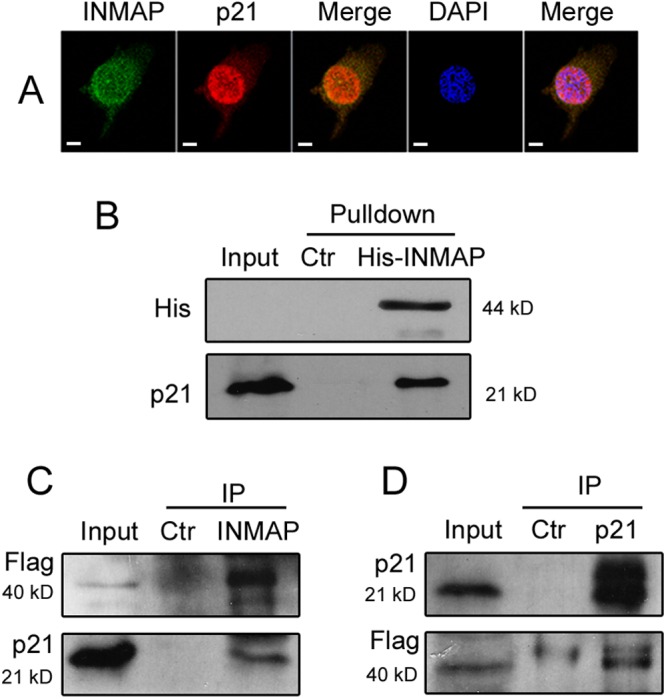
INMAP interacts with p21.(A). Colocalisation of INMAP and p21 in INMAP overexpression HeLa cells (Flag-INMAP). Cells were double-stained with mouse monoclonal anti-Flag antibody (green) and rabbit monoclonal anti-p21 antibody (red), and stained cells were analysed with IIF. Where green and red signals overlap (Merge), a yellow pattern is observed, indicating the colocalisation of INMAP and p21. Scale bars, 5 μm. (B). Pulldown assay of INMAP and p21. Expression vector pET30a-INMAP was transformed into Escherichia coli BL21. The purified His-INMAP fusion protein was added into HeLa cell extracts, incubated, and recovered on beads. pET30a (+) was a control. The Pulldown product was analysed by Western blotting. (C, D). CoIP assay of INMAP with p21. The proteins of HeLa cells that expressed Flag-INMAP were extracted and immunoprecipitated with the monoclonal Flag antibody (C) or p21 antibody (D). The same amount of purified mouse IgG (C) or rabbit IgG (D) was used in control samples. The immunoprecipitation (IP) result was analysed with SDS-PAGE and Western blot with anti-p21 or anti-Flag antibody.